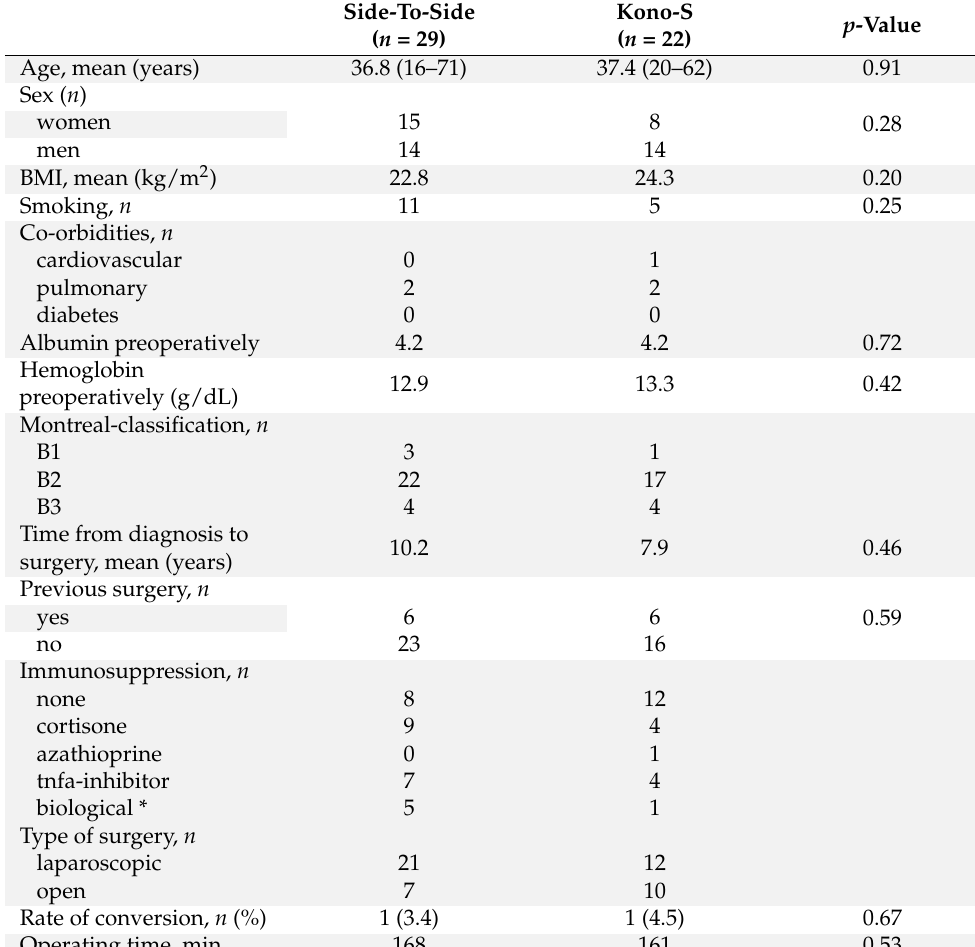
Table 1. Patient